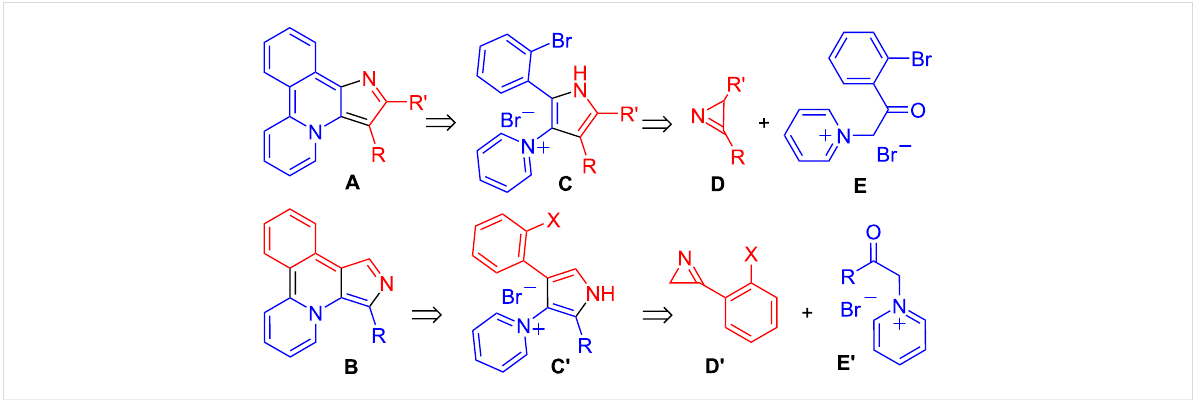
Scheme 1: Retrosynthetic analysis of heterocycles A and B .